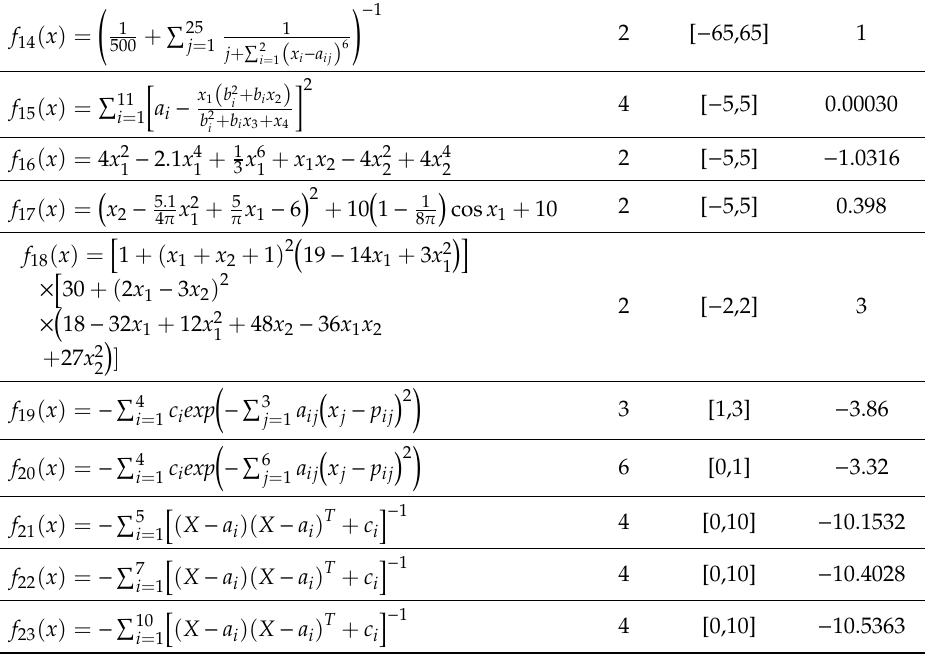
Table 3. Low-dimensional benchmark functions used in Test